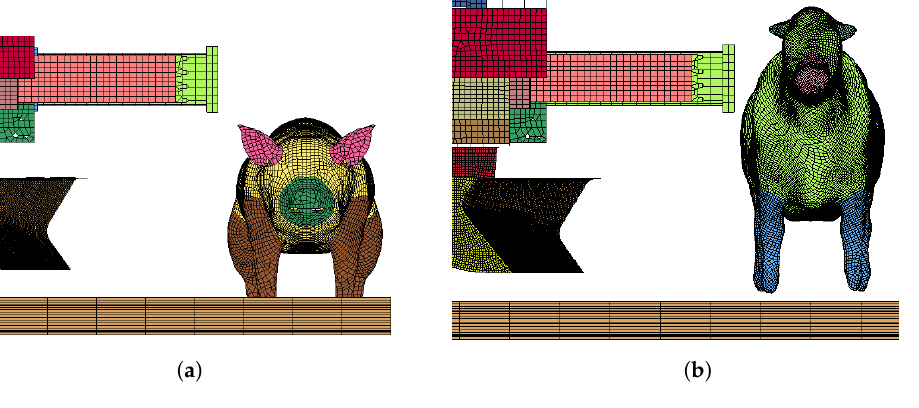
Figure 20. ( a ) Pig model; ( b ) Cow